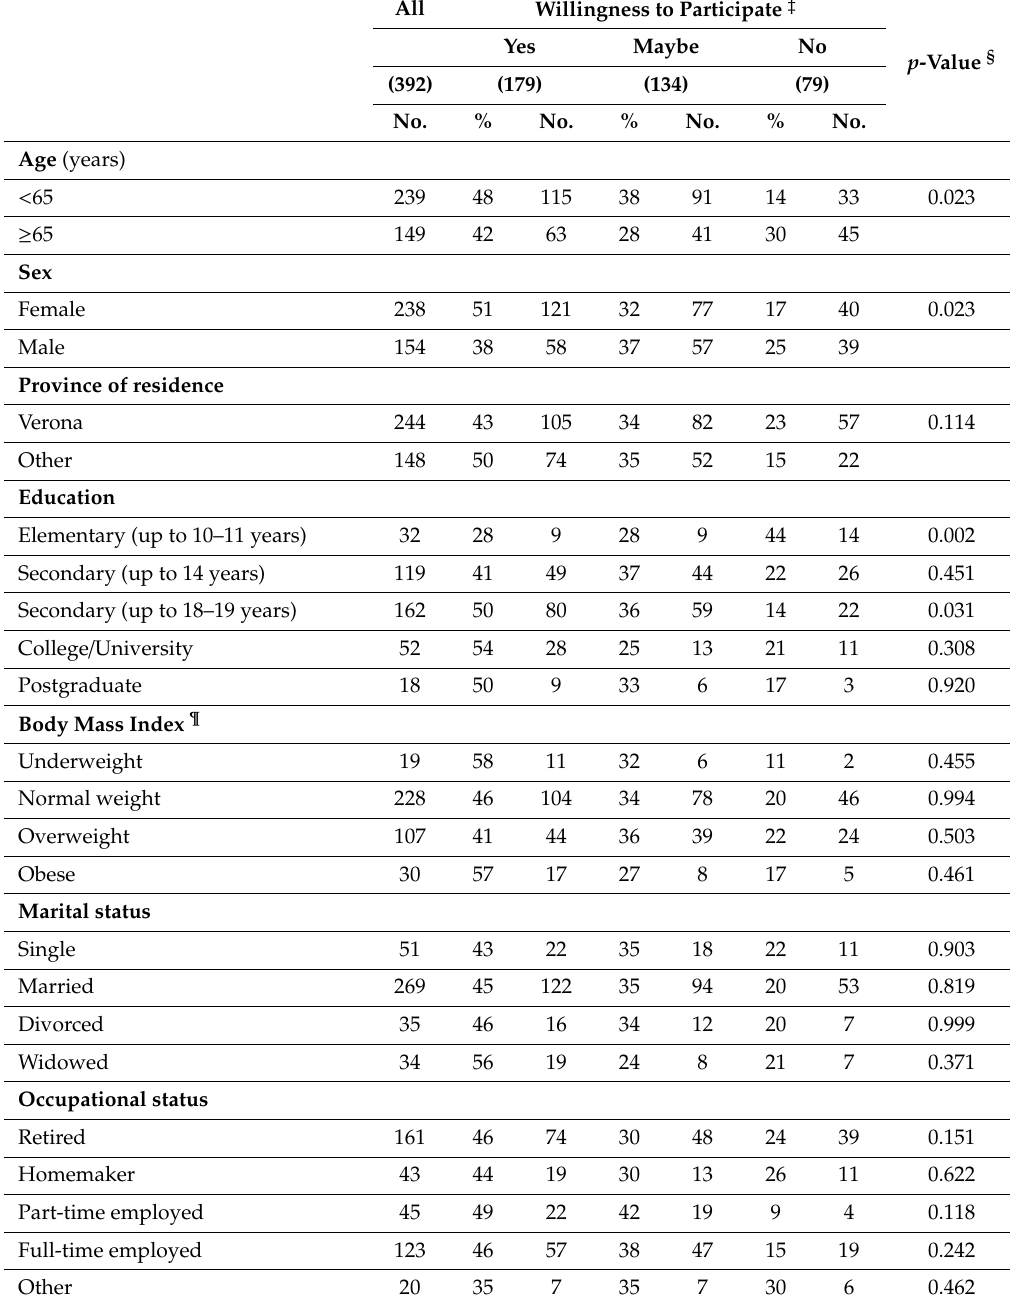
Table 1. General and tumor characteristics of 392 cancer patients † according to willingness to participate in a specifically designed exercise